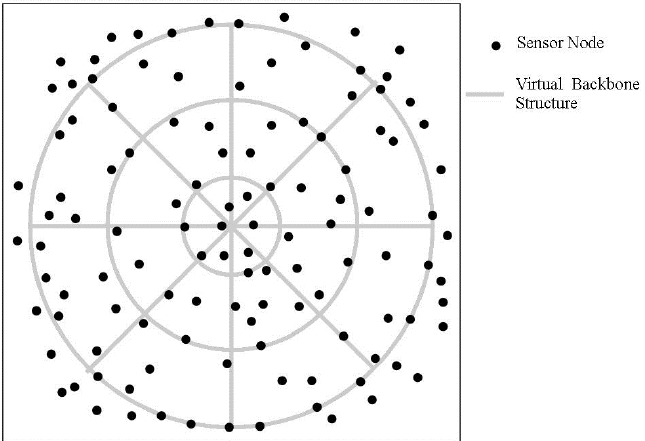
Figure 5. An example of virtual backbone structure in VCCSR